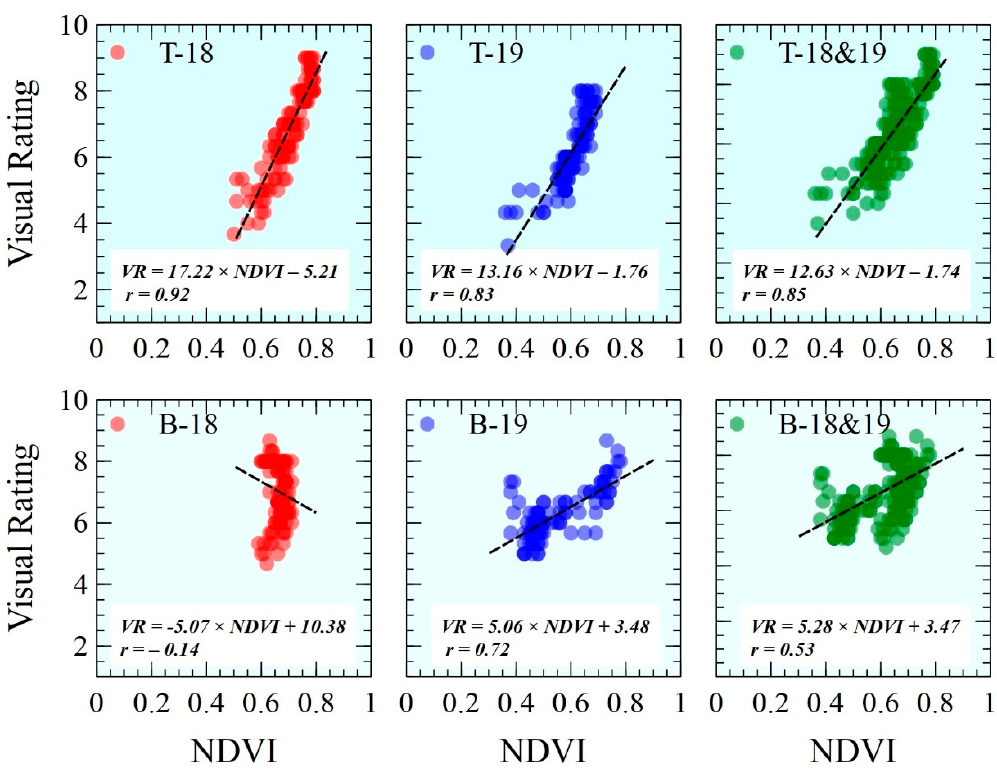
Figure 8. Relationship between visual rating (VR) and NDVI data collected in 2018 and 2019 from hybrid bermudagrass (B) and tall fescue (T) irrigation trials conducted at the University of California Kearney Research and Extension Center.